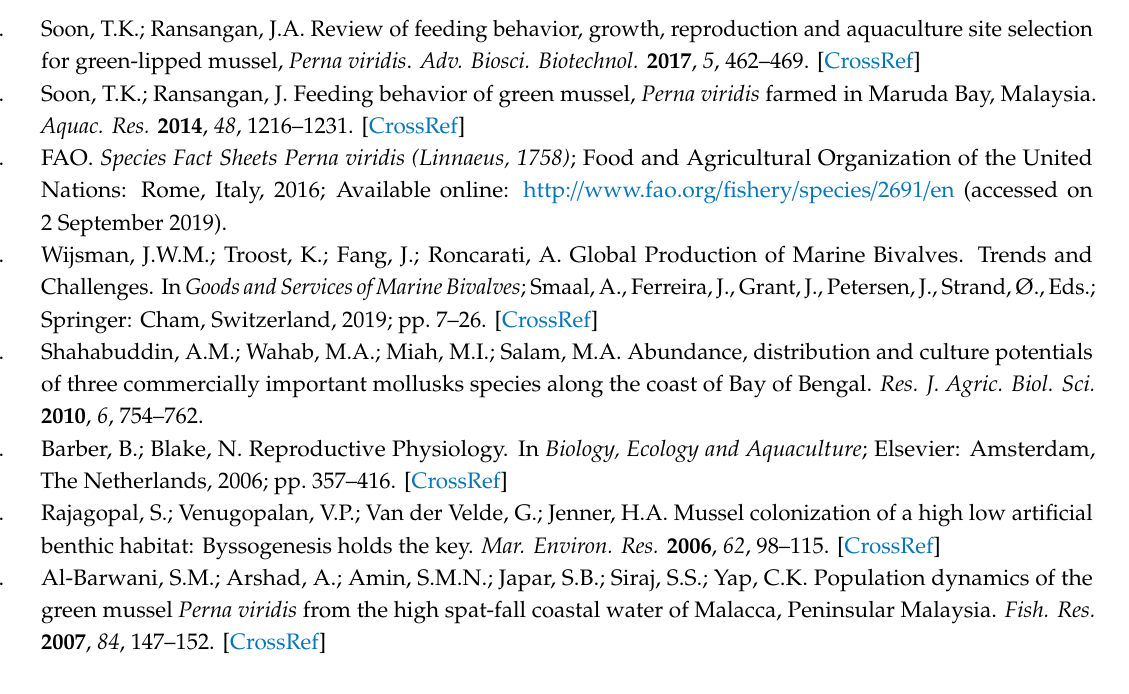
Figure S1: Macroscopic temporal variation of gonad development of green mussel Perna viridis collected from the coastal waters of Bangladesh, Table S1: Annual variation of water quality parameters of the green mussel Perna viridis collection sites during November 2017 to October 2018, Table S2: Annual variation of the major groups of ingested plankton (absolute abundance) in the whole gut of the green mussel Perna viridis , Table S3: Abundance of the major groups of ingested plankton in the whole gut at di ff erent gonadal development stages of the green mussel Perna viridis , Table S4: Annual variation in fatty acid content (% of total fatty acids) at di ff erent stages of gonad development of the green mussel Perna viridis , Table S5: Variation in fatty acid content (% of total fatty acids) of gonads in di ff erent gonadal development stages of the green mussel Perna viridis , Table S6: Principal component analysis of the water quality parameters of the green mussel collection sites, Table S7: Principal component analysis of di ff erent month-wise ingested gut plankton of green mussel Perna viridis , Table S8: Principal component analysis of di ff erent gonadal stage-wise ingested gut plankton of green mussel Perna viridis , Table S9: Table S10: Principal component analysis of di ff erent gonad development stage-wise fatty acids contents of green mussel Perna viridis , Table S11: Principal component analysis (PCA): relationships among the environmental factors, ingested gut plankton, lipids, and fatty acid content of gonad and GSI of green mussel Perna viridis. Author Contributions: Conceived, designed, and supervised the research: M.A. Performed fieldwork and collected data: A.R.N. (gonadal histology and other reproductive traits), S.A. (stomach content analysis for feeding behavior study), N.F.H. (ecological parameters), A.S. (field works, sampling, and sample preparation), M.A. (fatty acid analysis). Performed statistical analysis and interpreted the data: M.M.R. and M.A. Manuscript writing: M.A., A.R.N., S.A., N.F.H., and A.S. Critically reviewed and edited the manuscript: M.M.R. and M.A.W. All authors approved the final version of the